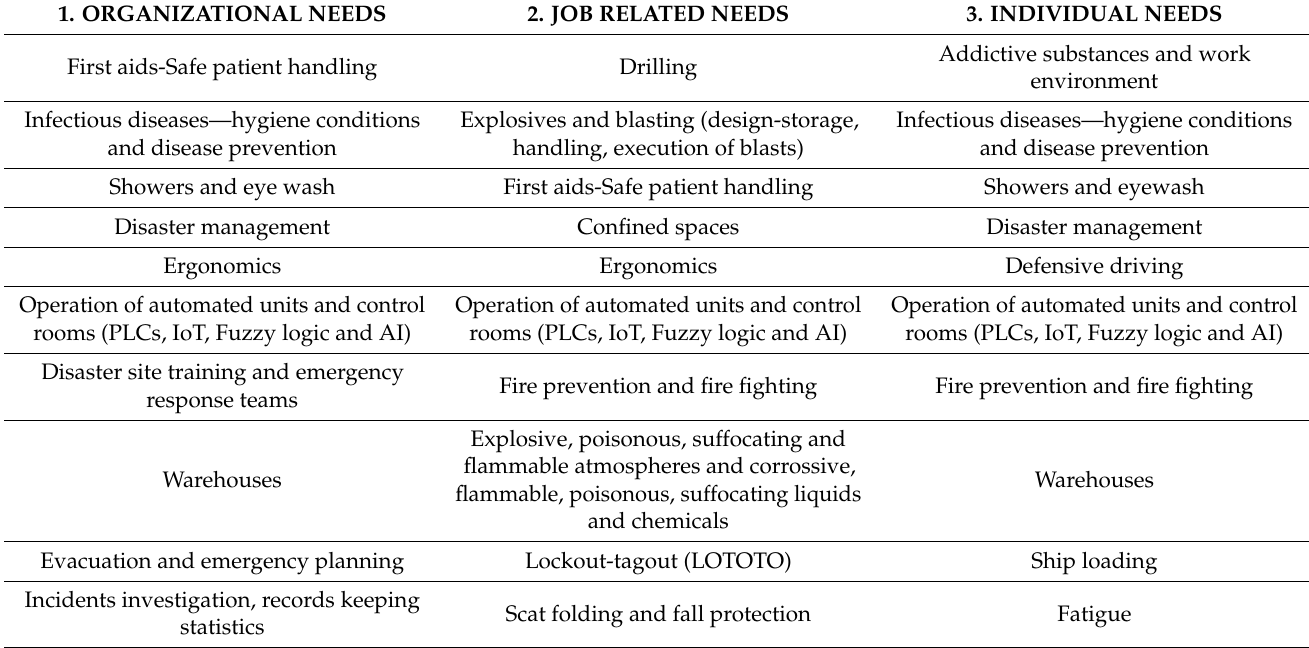
Table 1. Categorization of training material of Greek Mining Industry, according to training areas mentioned above